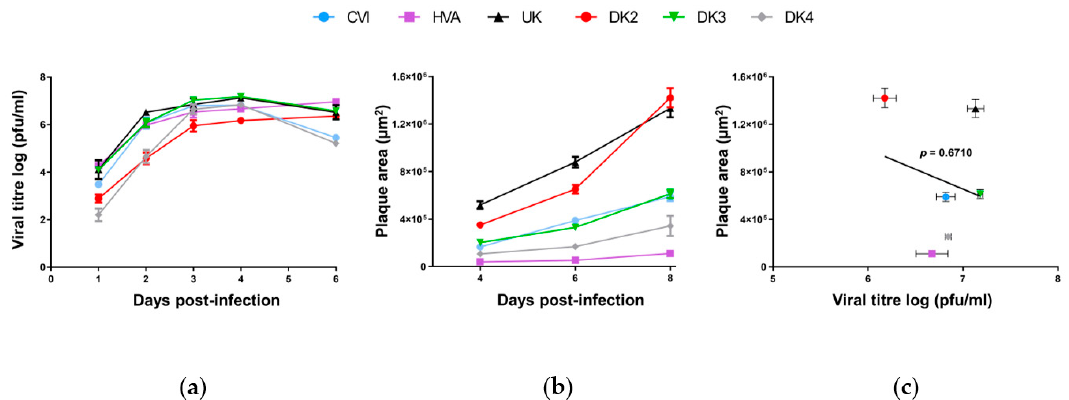
Figure 2. Comparisons of the growth of AngHV-1 strains in vitro. ( a ) Viral growth assay. EK-1 cells were infected with the strains indicated (see top for symbol codes) and the log 10 value of the titer (pfu/mL) in the cell supernatant was determined at the indicated dpi. Data are presented in Table 1. Cells were infected with the strains indicated, and plaque areas were measured over time. Data presented are the mean ± SEM for measurements of 20 randomly selected plaques. ( c ) Correlation between plaque area measured at 8 dpi (panel ( a )) and viral titers measured at 4 dpi (panel ( b )). Data presented are the mean ± SEM.